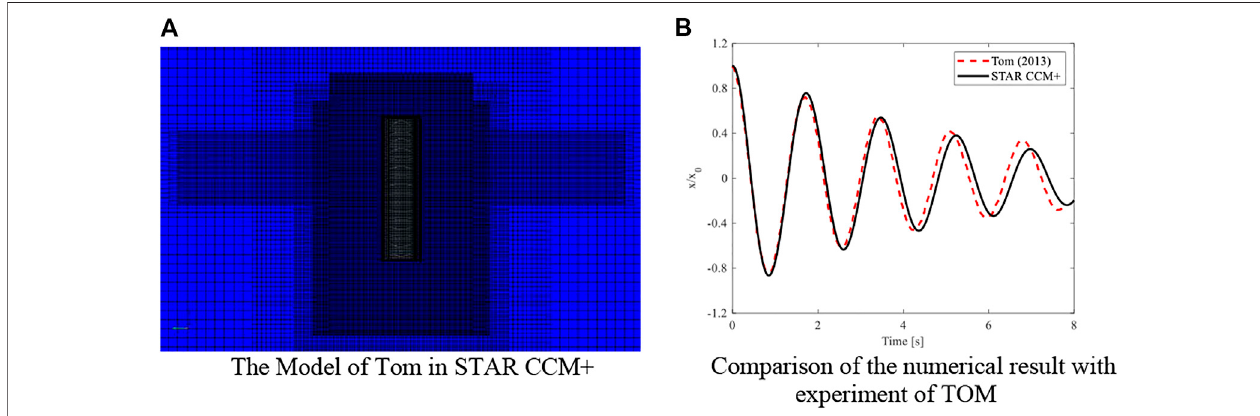
FIGURE 6 | Veri fi cation of the CFD method with the model of TOM. (A) The model of TOM in STAR CCM+. (B) Comparison of the numerical result with the experiment of TOM.